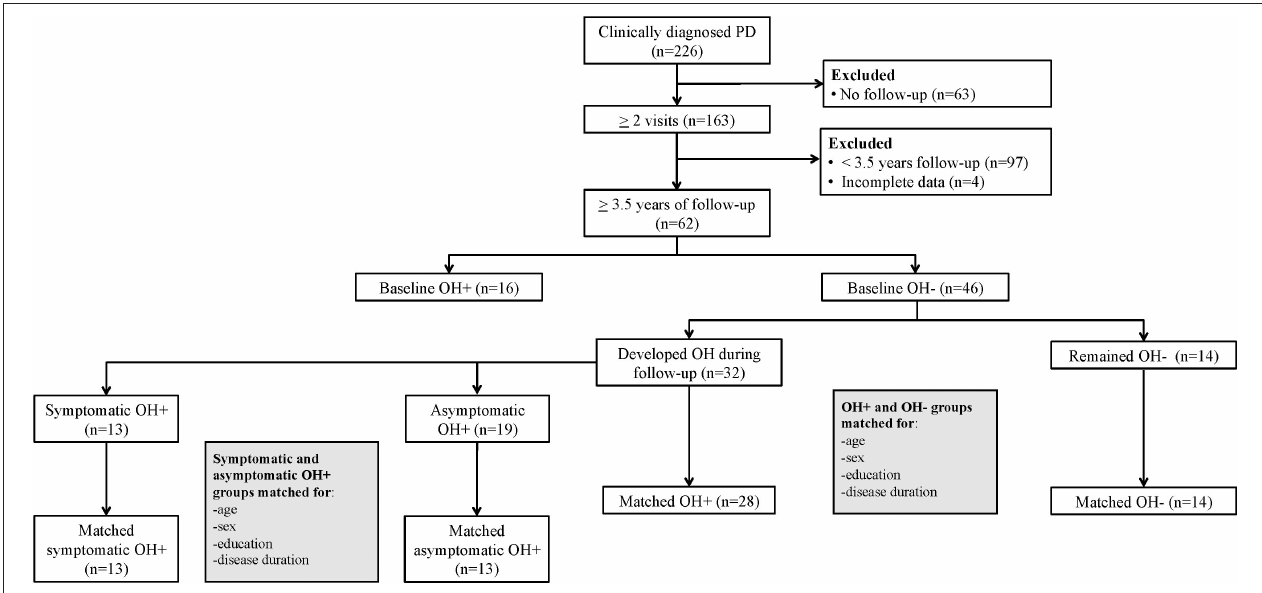
FIGURE 1 | Flow diagram of Parkinson disease (PD) patients with orthostatic hypotension (OH + ) and without OH (OH–) included in the longitudinal